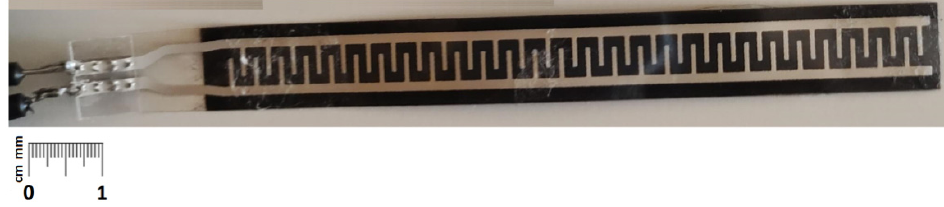
Figure 1. Flex sensor included in the prototype. The scale bar is included.